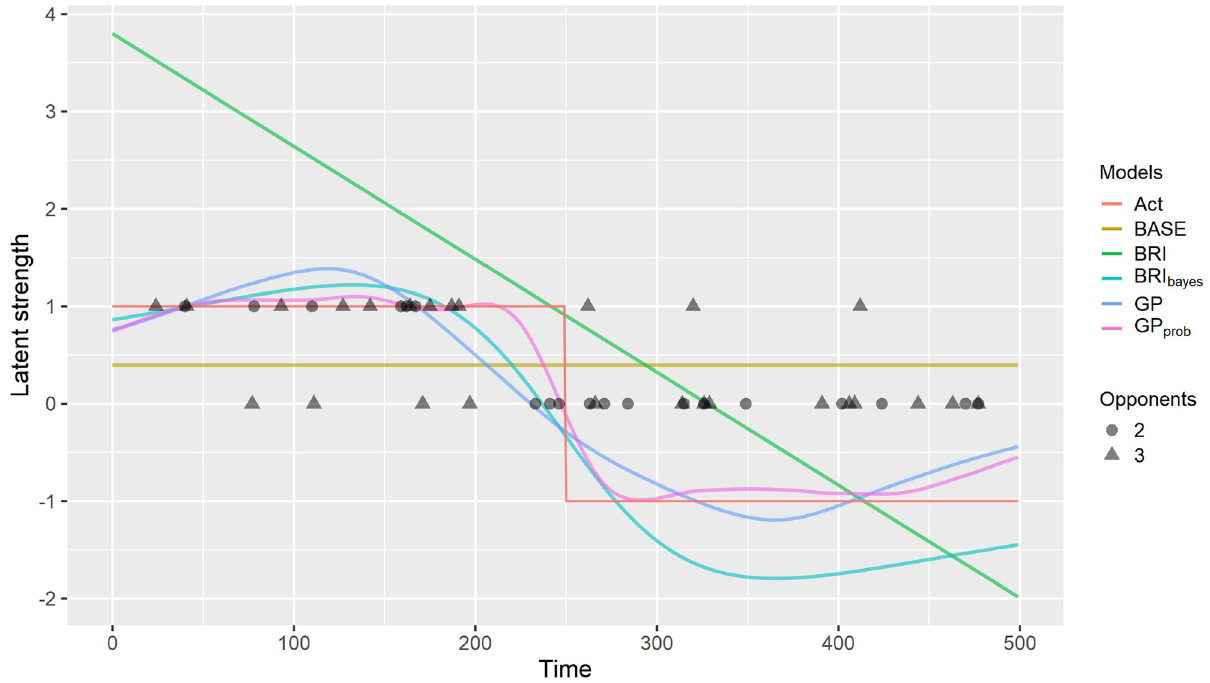
Fig 2. Model comparison of estimated latent strength for the 1st object in the toy data set. For models BRI bayes , GP and GP prob we show the posterior mean. The red line represents the true latent strength. The points represent the training data. GP fits the true latent strength better than BRI bayes . GP prob , which uses additional probability data fits the true latent strength